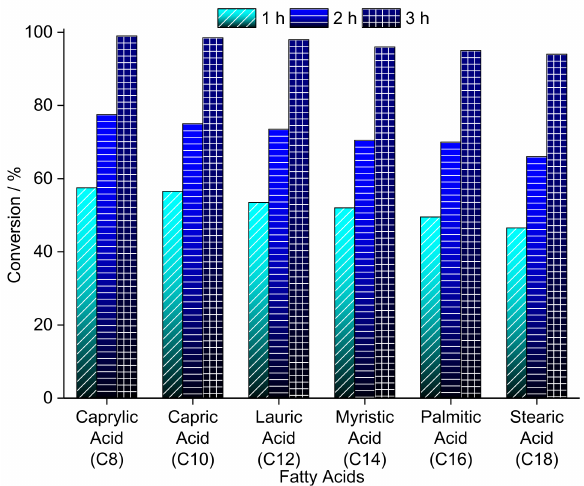
Figure 18. Different fatty acids esterification over Niobium oxide with methanol. Reaction conditions: fatty acid:methanol molar ratio (1:14), catalyst (15 wt% in relation to the fatty acid), temperature (65 ◦ C) (adapted from